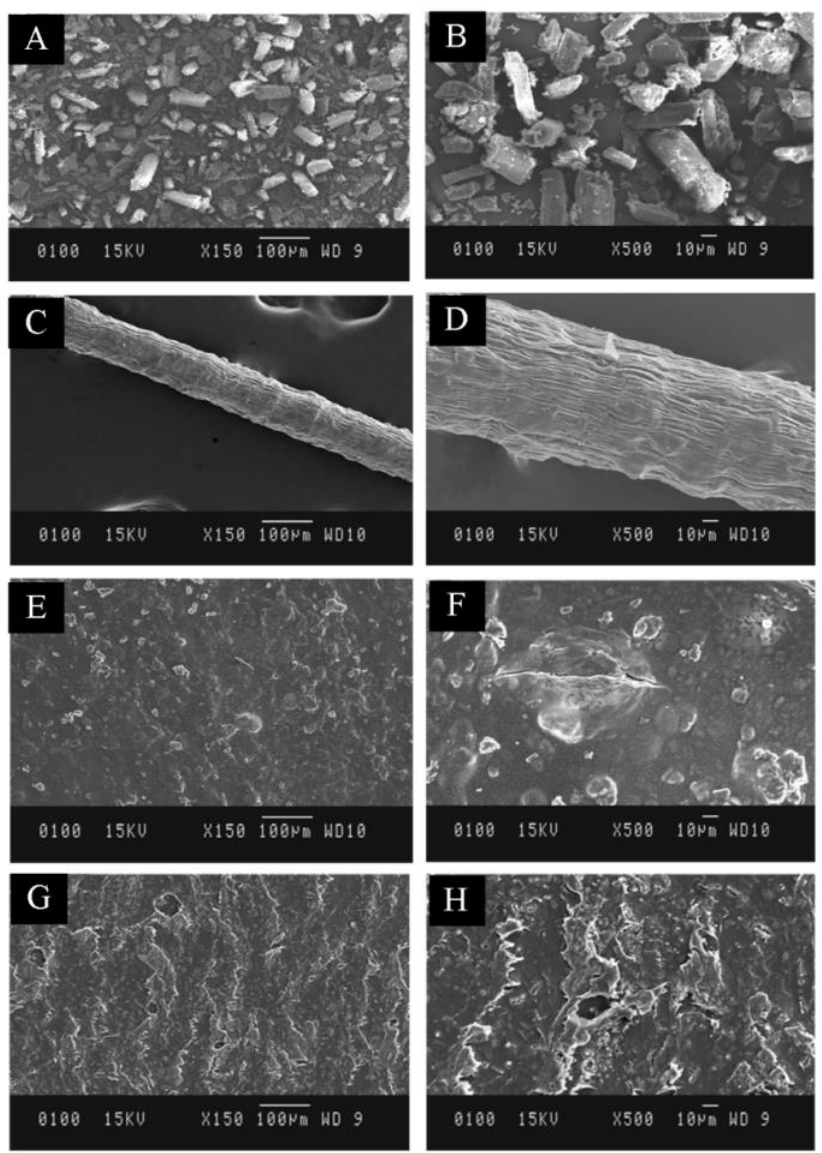
Figure 2. SEM images of different batches at magnification value ( A ) is 150× of drug; ( B ) is 500× of drug; ( C ) is 150 × of fiber; ( D ) is 500 × of fiber; ( E ) is 150 × of transdermal film (TF2); ( F ) is 500 × of drug; ( C ) is 150× of fiber; ( D ) is 500× of fiber; ( E ) is 150× of transdermal film (TF2); ( F ) is 500× of transdermal film (TF2); ( G ) is 150 × of transdermal film (TF4); ( H ) is 500 × of transdermal film transdermal film (TF2); ( G ) is 150× of transdermal film (TF4); ( H ) is 500× of transdermal film (TF4).